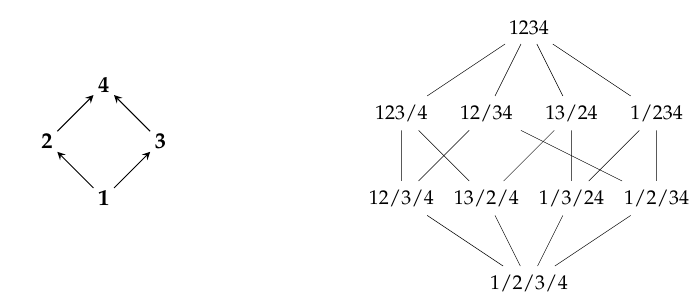
Figure 1. A poset P and its lattice of closed face